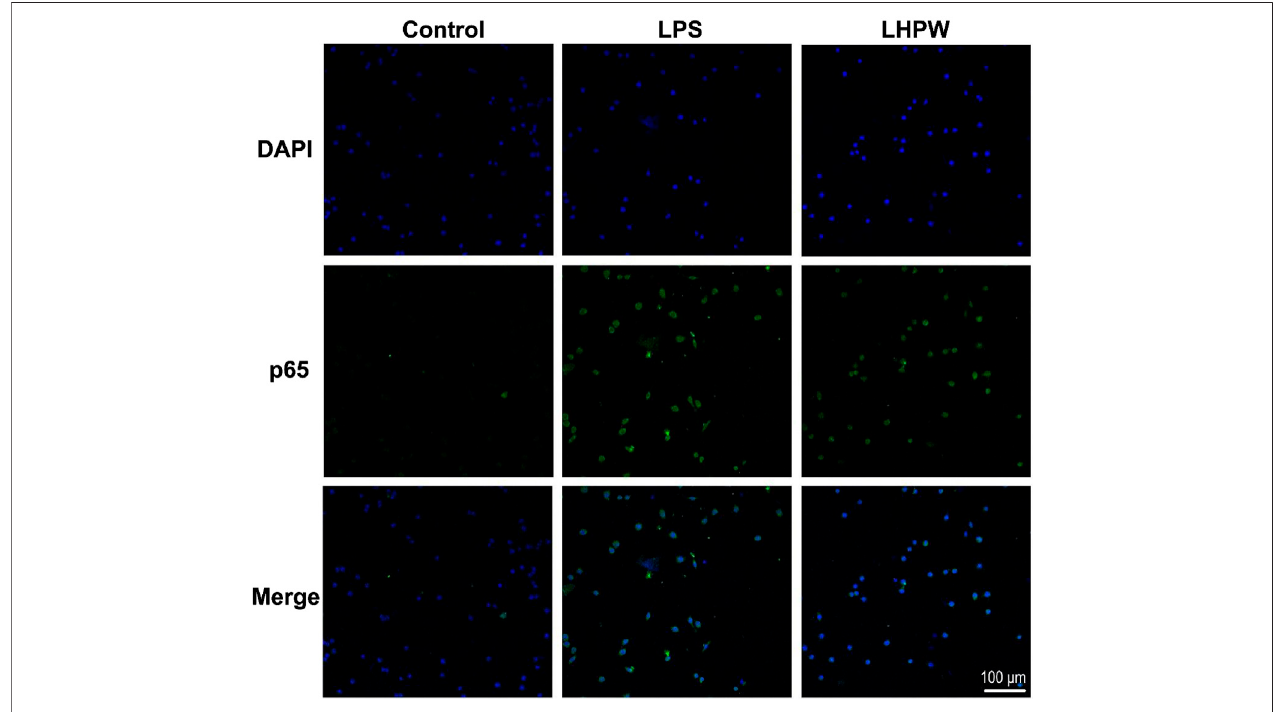
FIGURE 5 | LHPW activates the NF- κ B p65 protein in RAW 264.7 cells. After being treated with 200 μ g/ml LHPW or 2 μ g/ml LPS for 3 h, NF- κ B p65 protein translocated into nuclei (DAPI) was obtained by laser confocal microscopy. The scale bar was placed at the bottom right, and all images have the same scales.